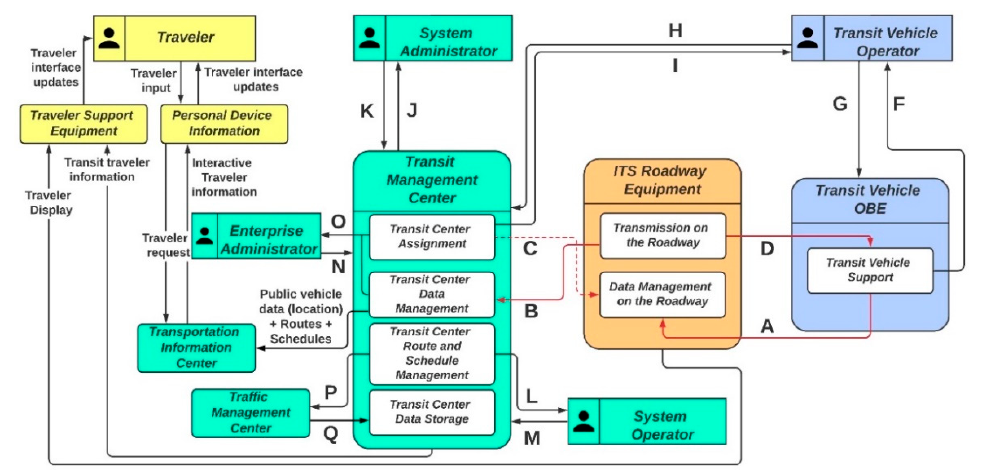
Figure 3. Intelligent Transportation System (ITS) architecture proposal for FMCS.